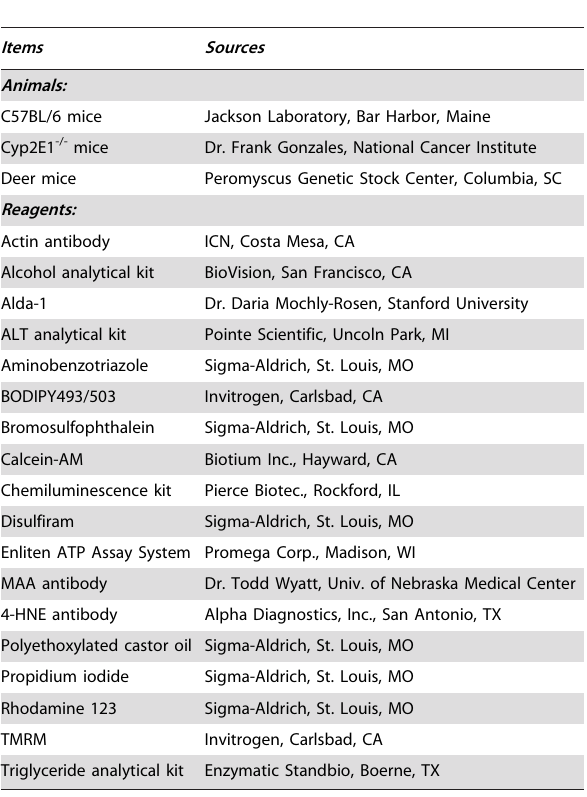
Table 1. Sources for Animals and